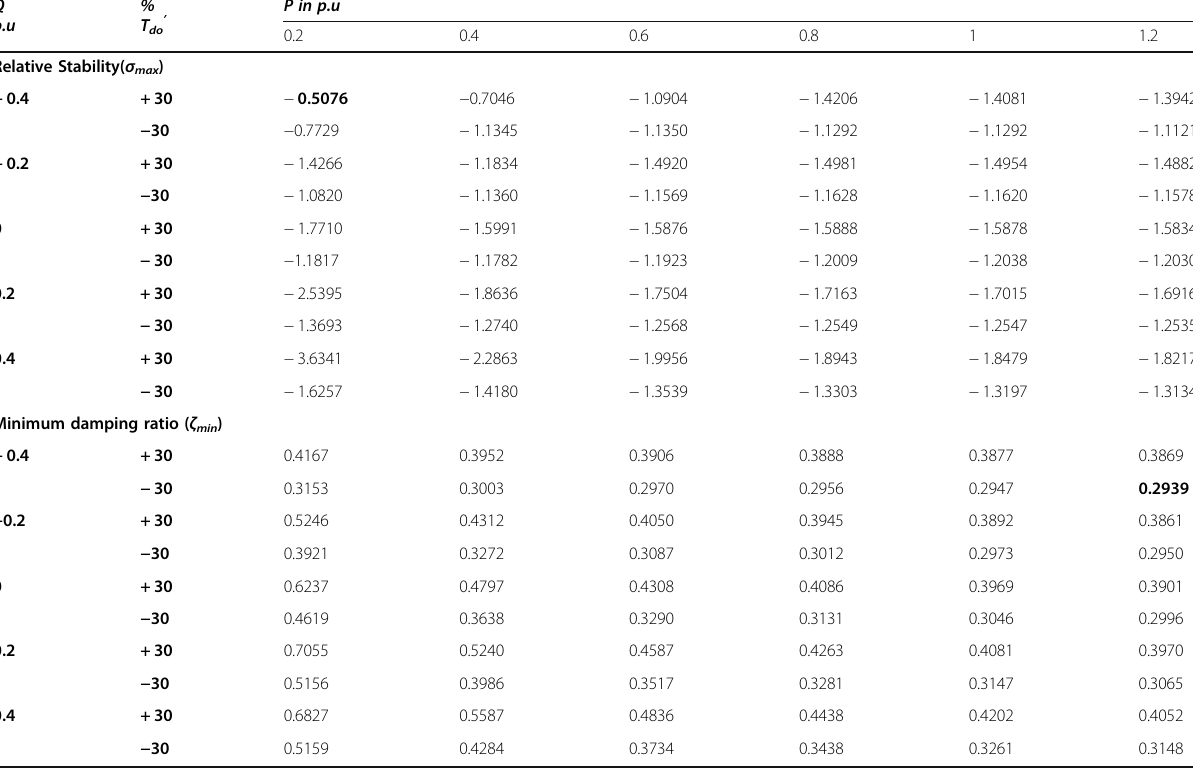
Table 3 Relative stability and minimum damping ratio for ±30% changes in field time constant T do ’ Q